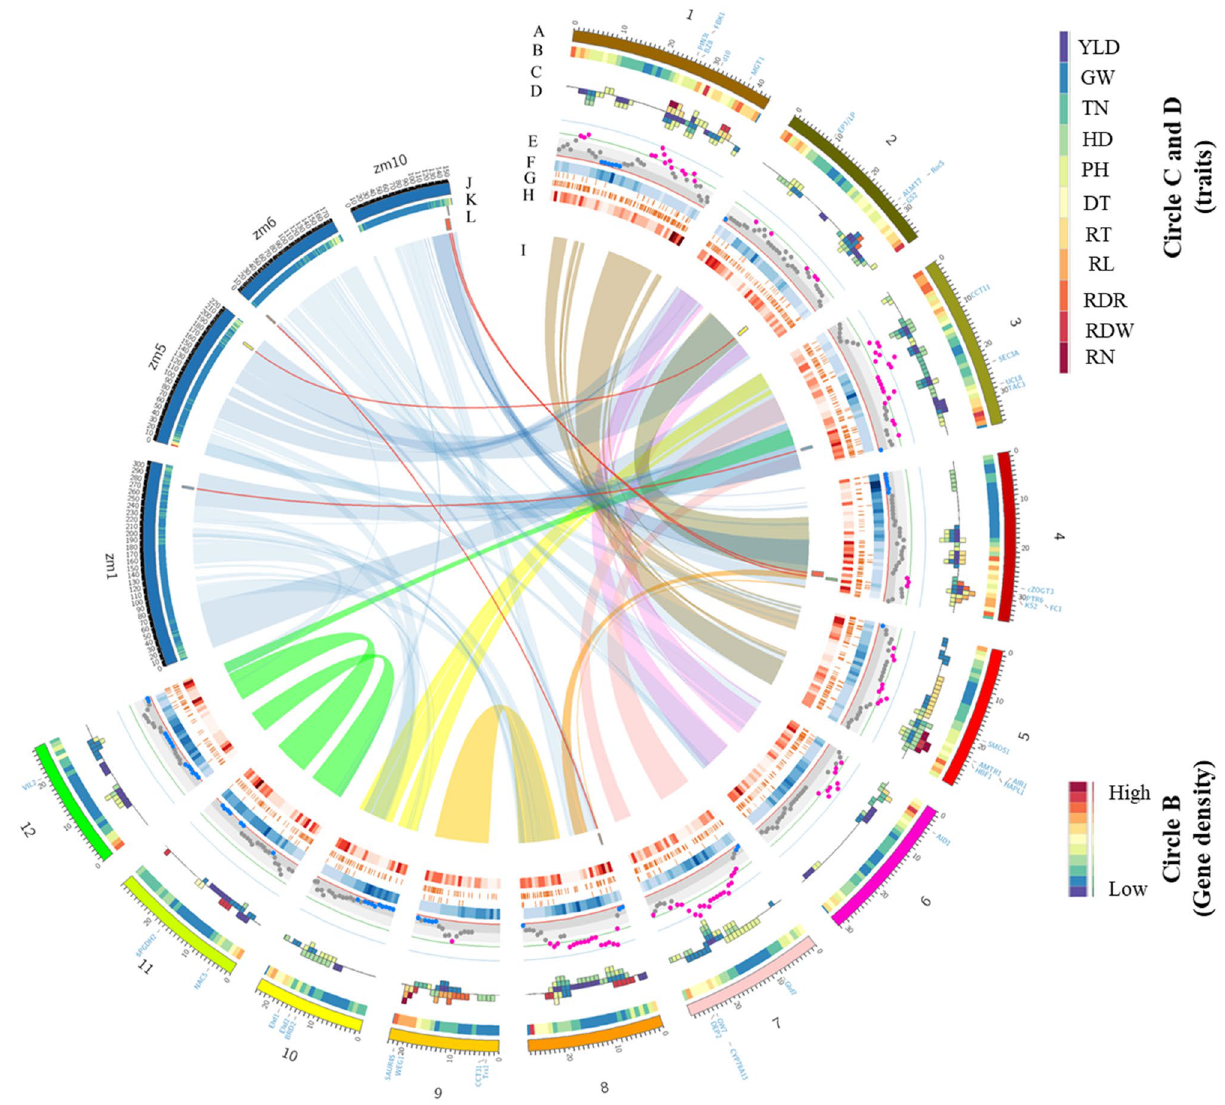
Figure 3. The distribution pattern of ( A ) functionally characterized genes on rice chromosomes, ( B ) gene density on rice chromosomes, ( C ) MQTLs under water deficit condition for different traits indicated in the color scale on the right side, ( D ) MQTLs under normal condition for different traits indicated in the color scale on the right side, ( E ) QTLs density, ( F ) SNP density shown in white to dark blue scale for the lowest to the highest density, ( G ) Structural variants (SV) density shown in white to dark red scale for the lowest to the highest density, ( H ) recombination density shown in white to dark red scale for the lowest to the highest density, ( I ) rice duplicated regions and rice syntenic regions with maize in light blue, ( J ) maize chromosomes with orthologous MQTLs with rice, ( K ) gene density on the maize chromosomes and ( L ) ortho-MQTLs between rice and maize. The outermost circle represents the rice genome in